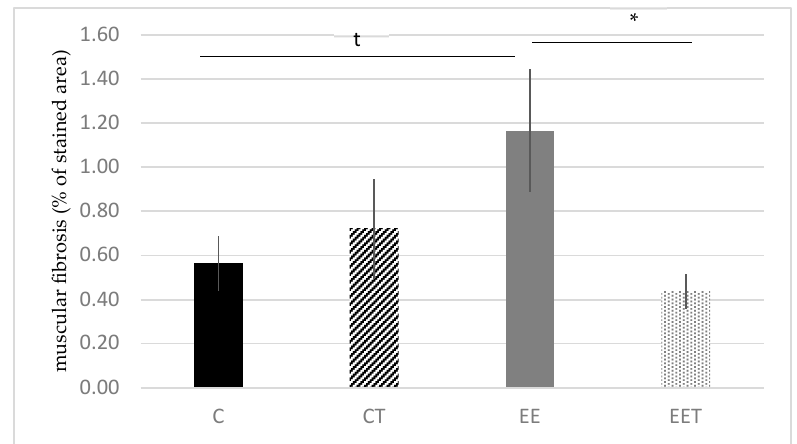
Figure 3. Influence of melon concentrate supplementation on the muscular fibrosis (gastrocnemius muscle). Muscular fibrosis measured on five transverse sections per muscle. Results are expressed as percentage of fibrous tissue area stained with picrosirius red ± SEM. t p < 0.1 effect of the eccentric exercise compared with control group, * < 0.05 effect of melon concentrate supplement compared with the EE group.